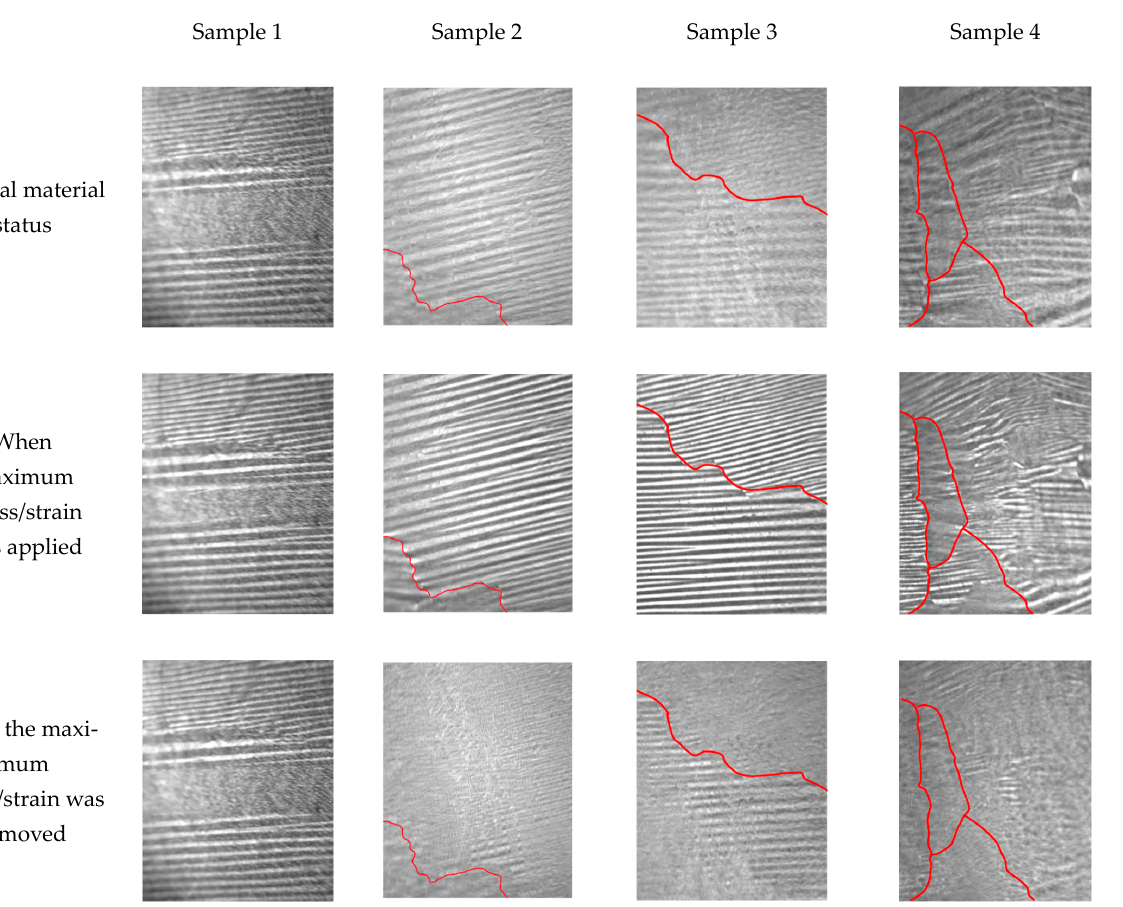
Figure 3. Domain images of samples in different material statuses. The red lines represent the grain boundaries. grain